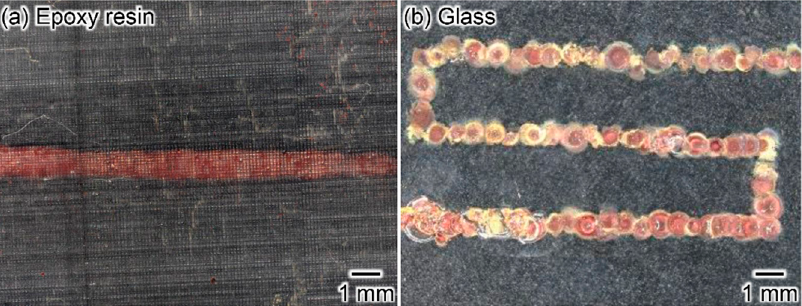
Figure 8. A demonstration of copper patterning. ( a , b ) Metal deposition by scanning the bubble injector in a I and S shape.